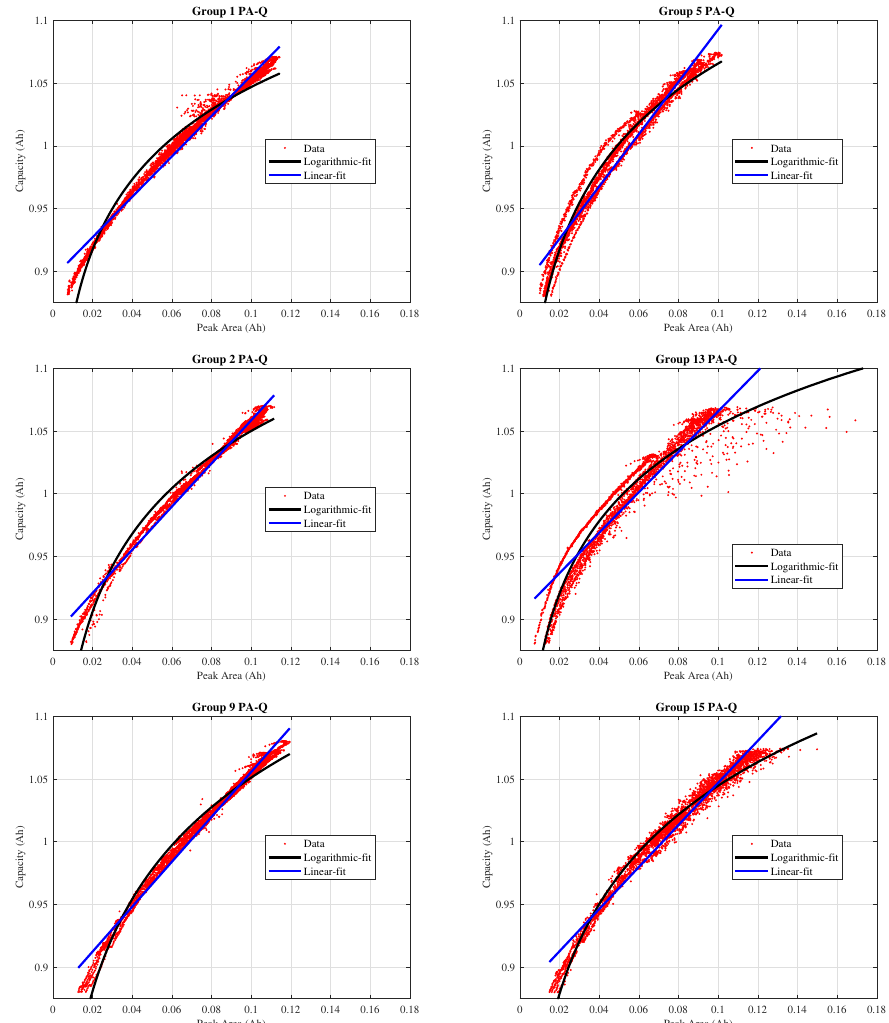
Figure 7. Capacity Q as a function of the peak area PA for various battery